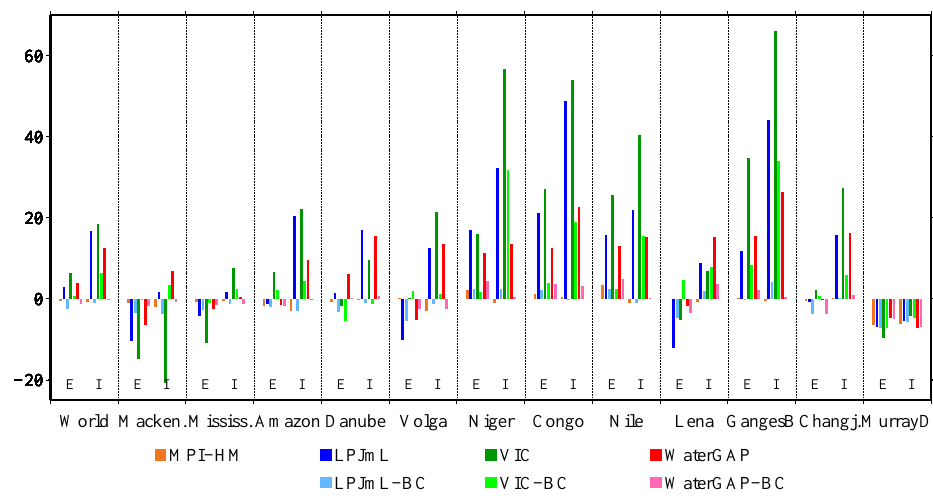
Fig. 4. Annual mean evapotranspiration differences (percent), with and without bias correction (BC) for the period 1971–2000 for the LPJmL, VIC and WaterGAP models when using WDD (ECHAM (E) and IPSL (I)), compared to the results using WFD. MPI-HM results using WDD, compared to the results using WFD, are included for reference purposes.